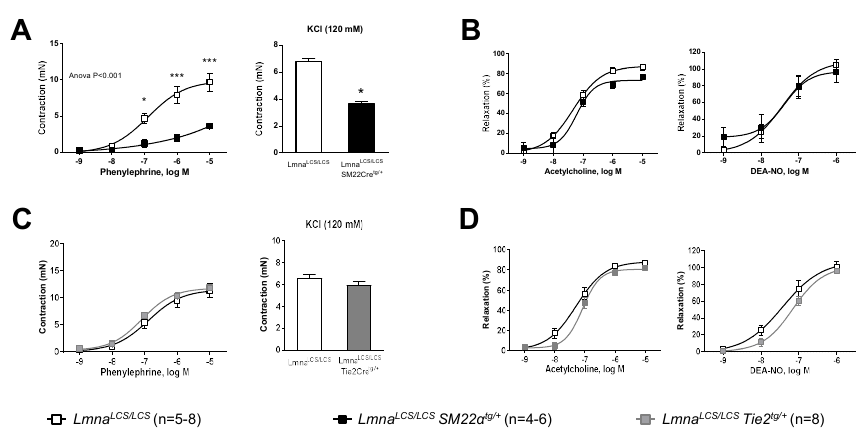
Figure 3. Progerin expression restricted to VSMCs impairs aortic contraction, but VSMC-specific and EC-specific progerin expression is not sufficient to cause defective vessel relaxation. Wire myography was performed in thoracic aorta rings from 14-week-old mice expressing progerin specifically in VSMCs ( Lmna LCS/LCS SM22α tg/+ ) or in ECs ( Lmna LCS/LCS Tie2 tg/+ ) and in control mice without progerin expression ( Lmna LCS/LCS ). ( A ) Contraction induced by phenylephrine (left) and KCl (right) in aortic rings from Lmna LCS/LCS SM22α tg/+ mice and Lmna LCS/LCS controls. ( B ) Endothelium-dependent vasodilation induced by acetylcholine (left) and endothelium-independent vasodilation induced by diethylamine NONOate (DEA-NO) (right) in aortic rings from Lmna LCS/LCS SM22α tg/+ mice and Lmna LCS/LCS controls. ( C ) Contraction induced by phenylephrine (left) and KCl (right) in aortic rings from Lmna LCS/LCS Tie2 tg/+ mice and Lmna LCS/LCS controls. ( D ) Endothelium-dependent vasodilation induced by acetylcholine (left) and endothelium-independent vasodilation induced by DEA-NO (right) in aortic rings from Lmna LCS/LCS Tie2 tg/+ mice and Lmna LCS/LCS controls. Statistical differences were analyzed by two-way ANOVA with Bonferroni’s post-hoc test for acethylcholine, DEA-NO, and phenylephrine data, and by two-tailed t-test for KCl data. * p < 0.05; *** p < 0.001.